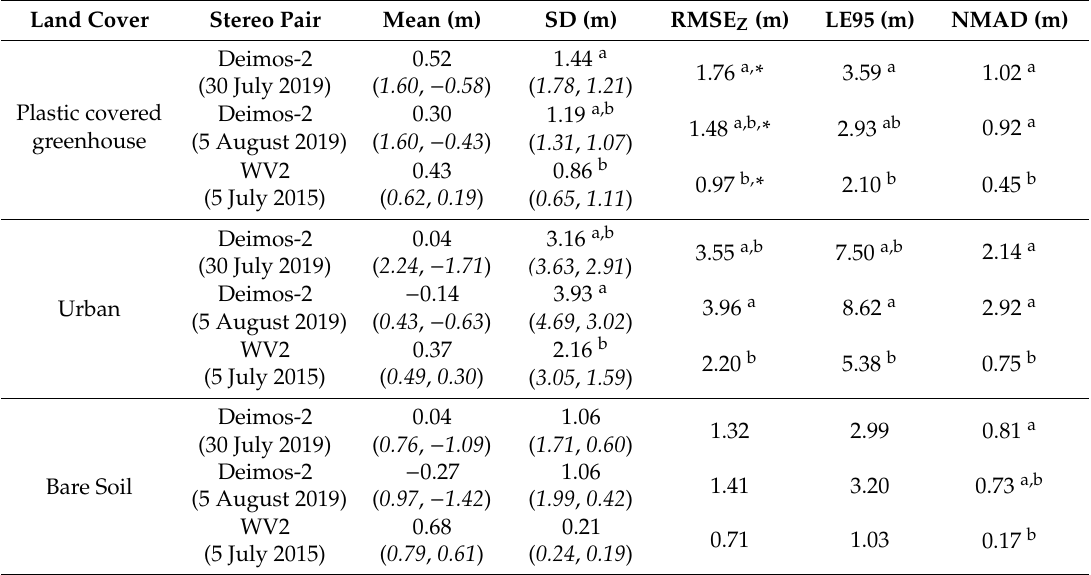
Table 6. Vertical accuracy (mean, SD, RMSE Z , 95th percentile linear error (LE95) and normalized median absolute deviation (NMAD)) computed at LiDAR reference ICPs. All the depicted values are mean values corresponding to three samples for each land cover. Minimum and maximum values for the three samples are depicted in brackets and italic font for mean and SD. For each land cover, di ff erent superscript letters between data along the same column indicate significant di ff erences at